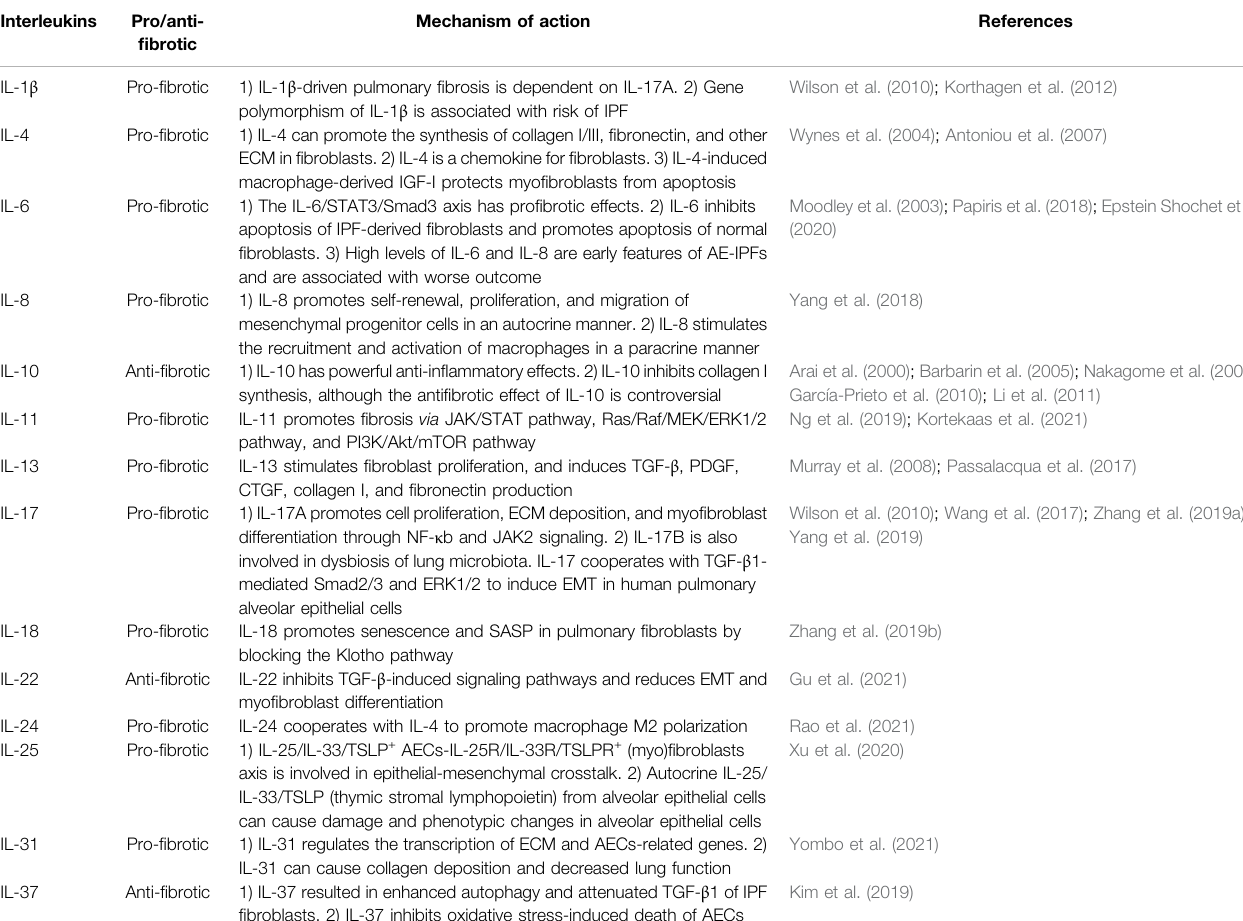
TABLE 1 | The role and underlying mechanism of interleukins in